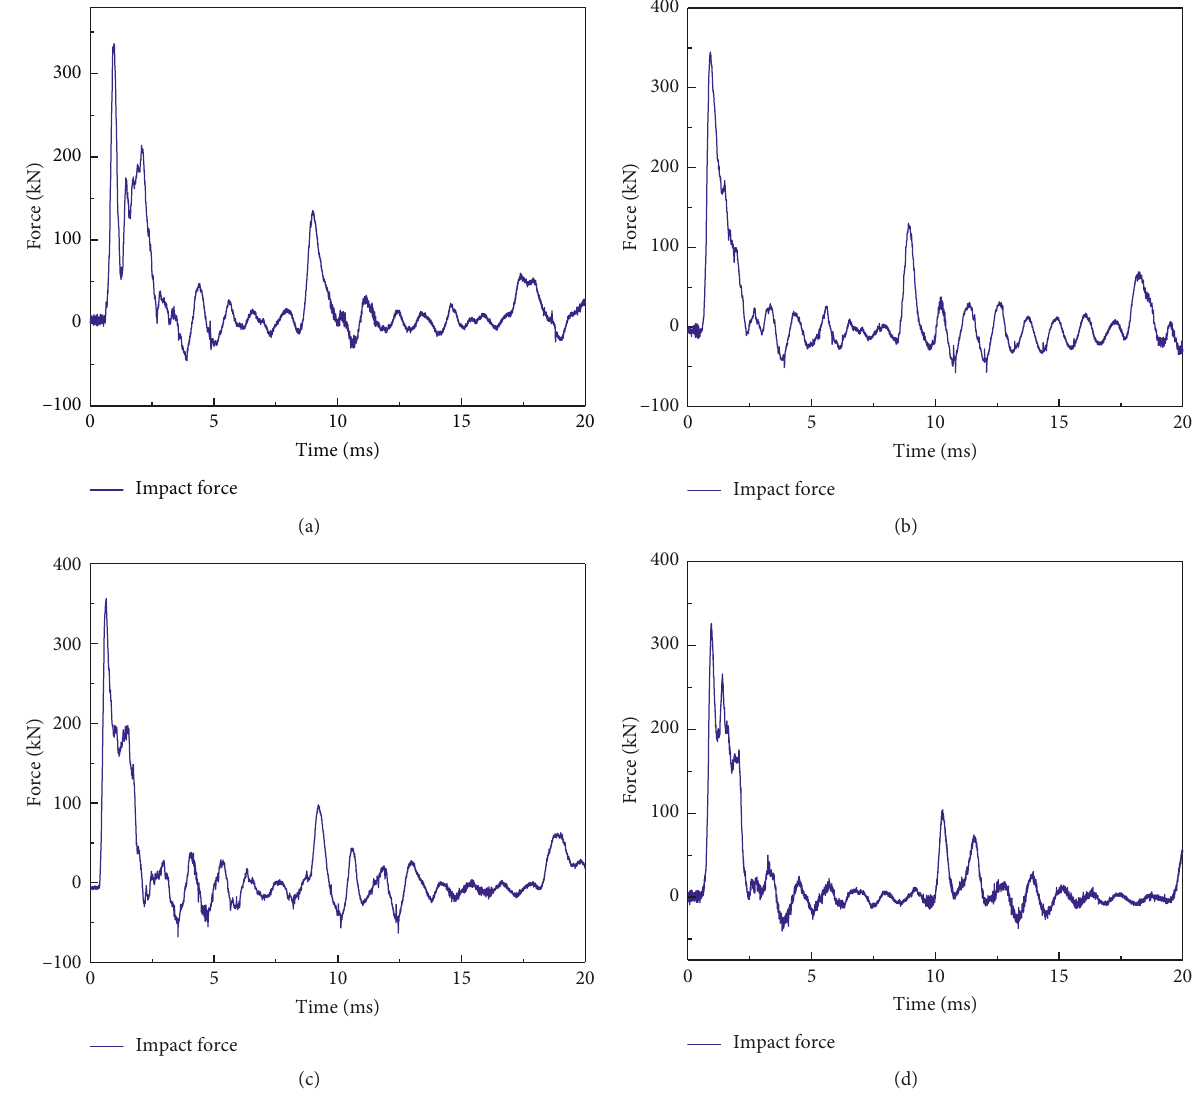
Figure 7: The curves of the impact force. (a) T-1, (b) T-2, (c) T-3, and (d)